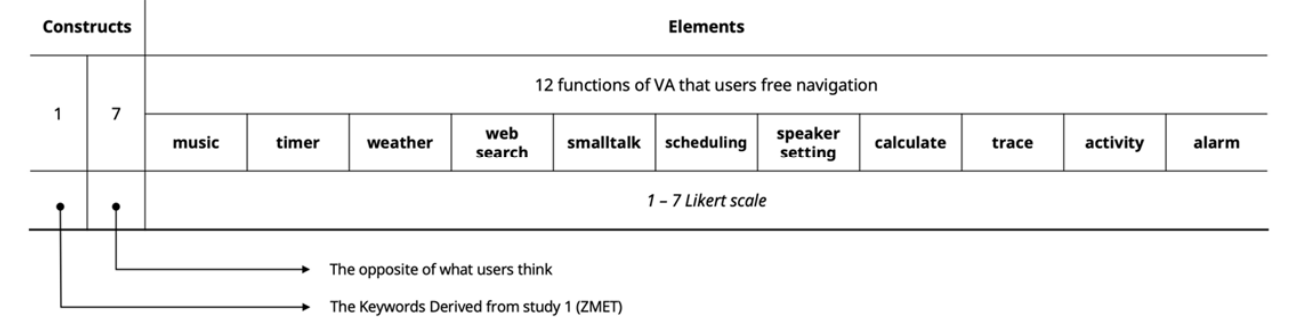
Figure 4. The structure of the Repertory Grid.